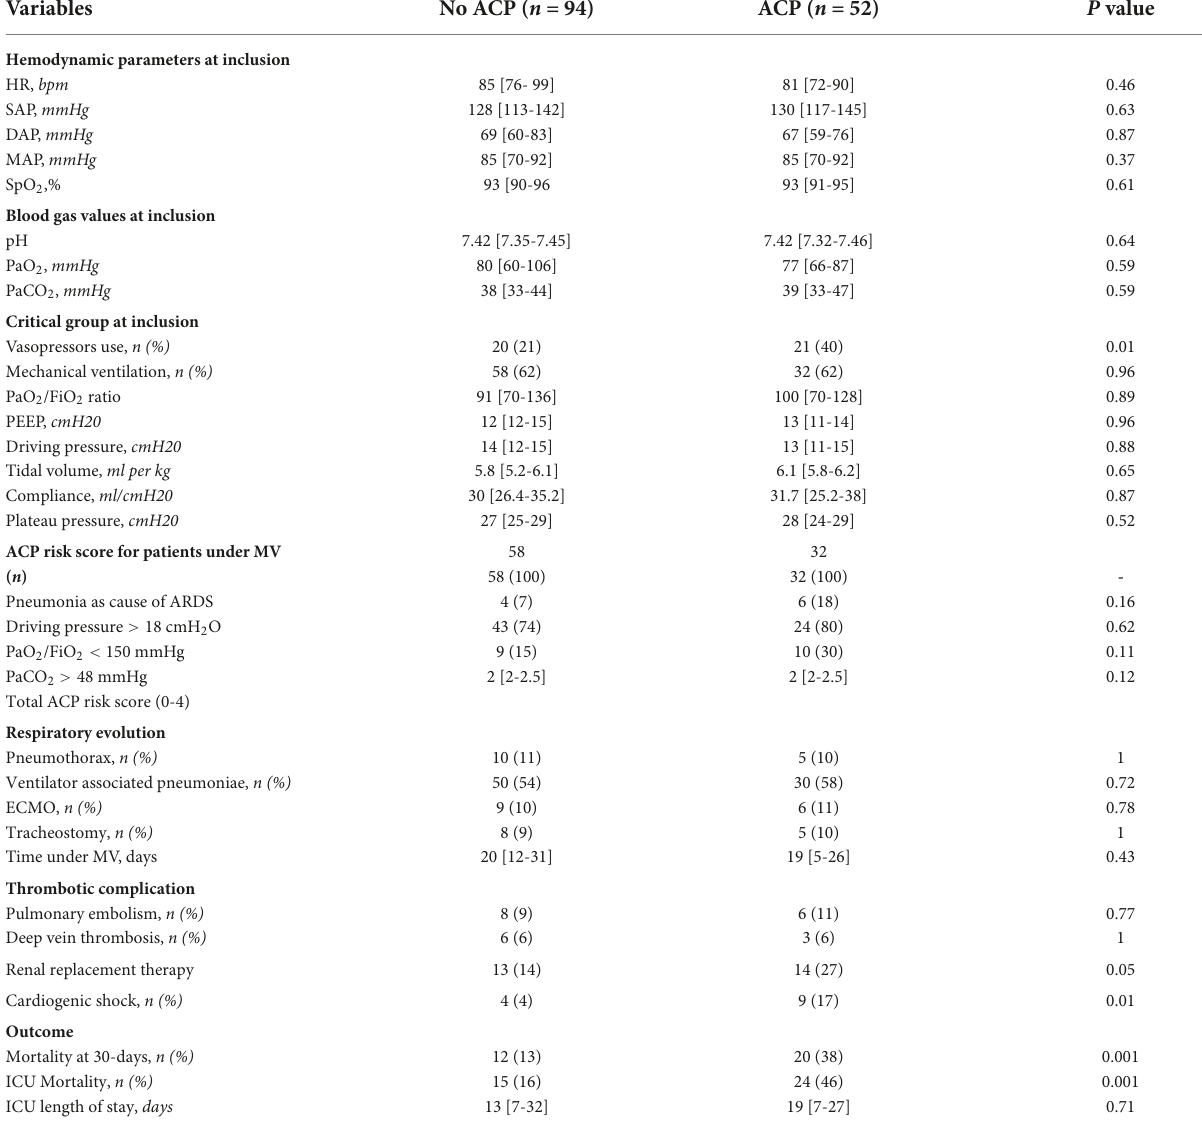
TABLE 3 Clinical characteristics and outcomes of patients having COVID-19-related pneumonia with and without acute cor pulmonale. Variables No ACP ( n = 94) ACP ( n = 52) P